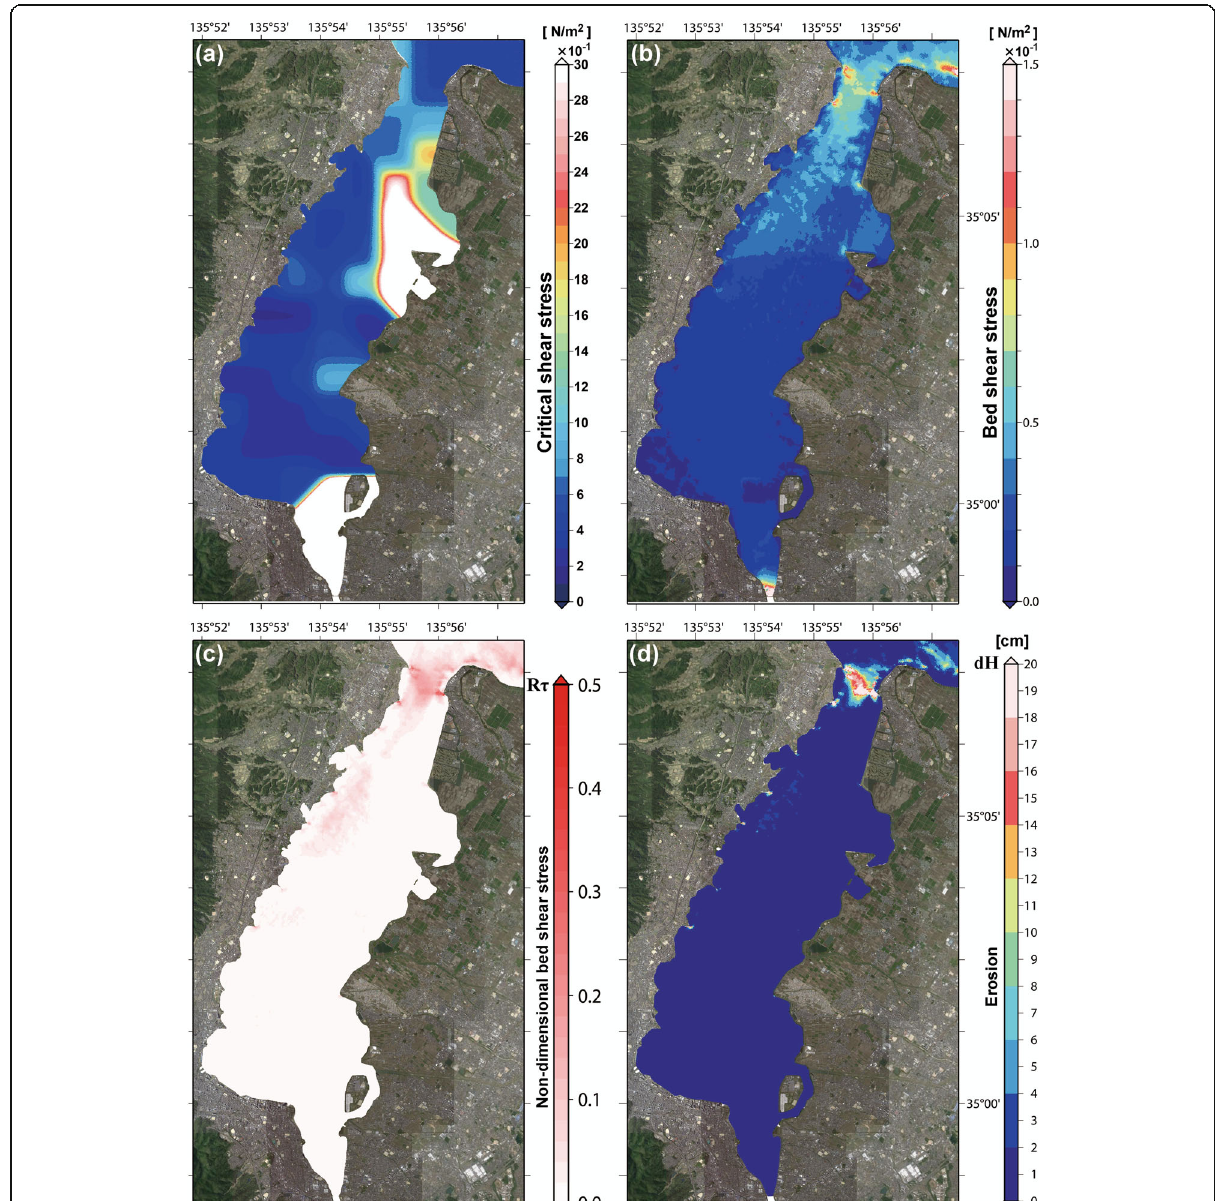
Fig. 14 Maps of a the critical shear stress, b the time-averaged bed shear stress, c the time-averaged nondimensional bed shear stress, and d the time-integrated erosion from the lakebed during the period 0:00 – 23:50 JST on 4